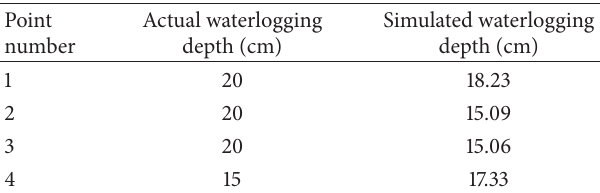
Table 6: The contrast of actual waterlogging depth and simulated waterlogging depth.